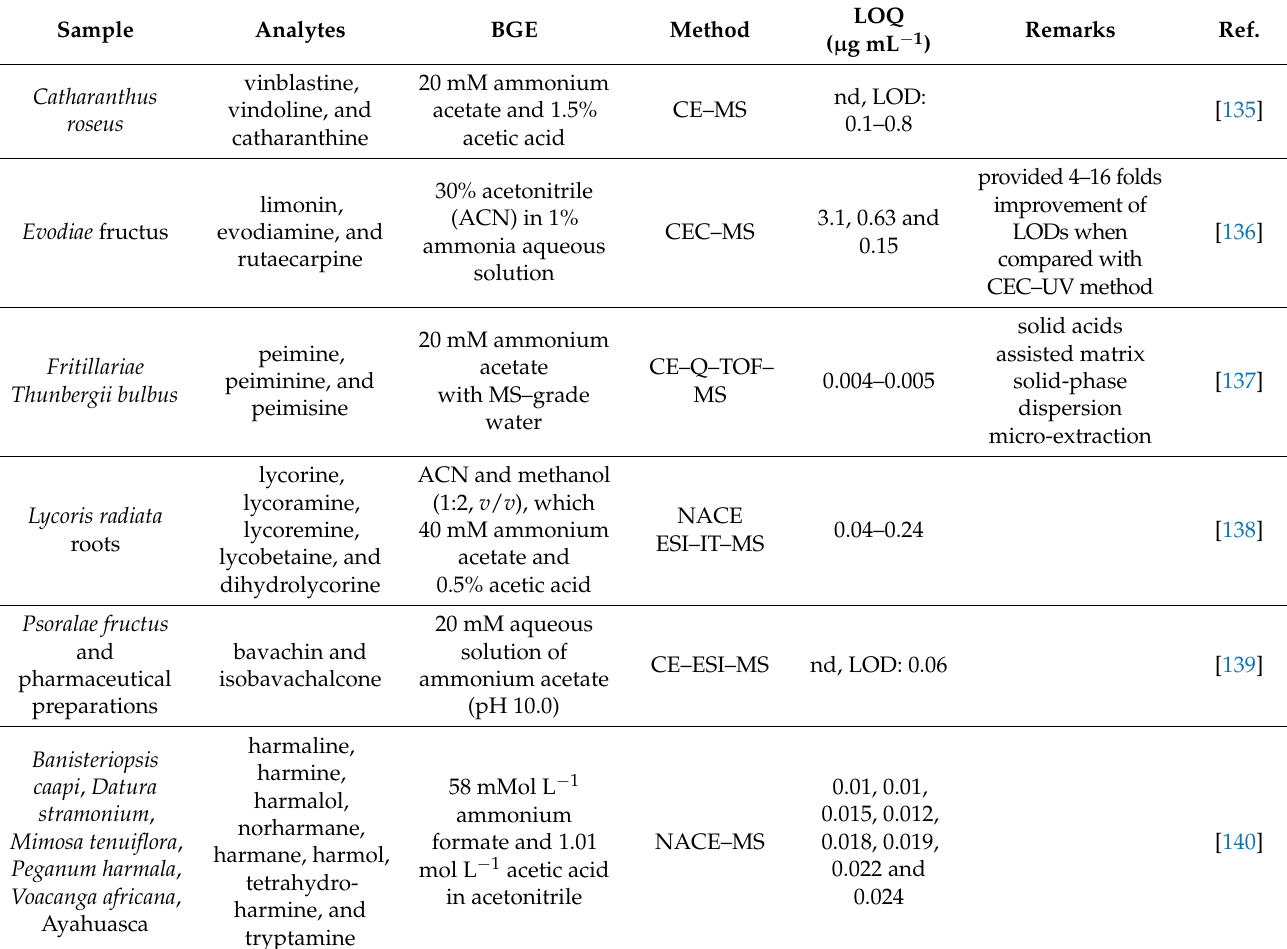
Table 5. Application of capillary electrophoresis with MS